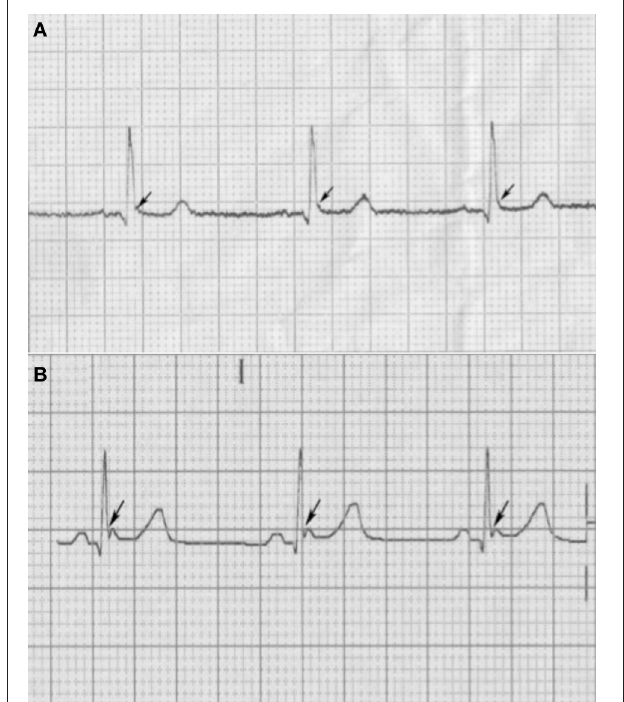
FIGURE 1 | The identification of ER from the 12-lead electrocardiogram. (A) Shows a typical example of a slurred patterned ER (arrows) while (B) shows the appearance of a notched ER